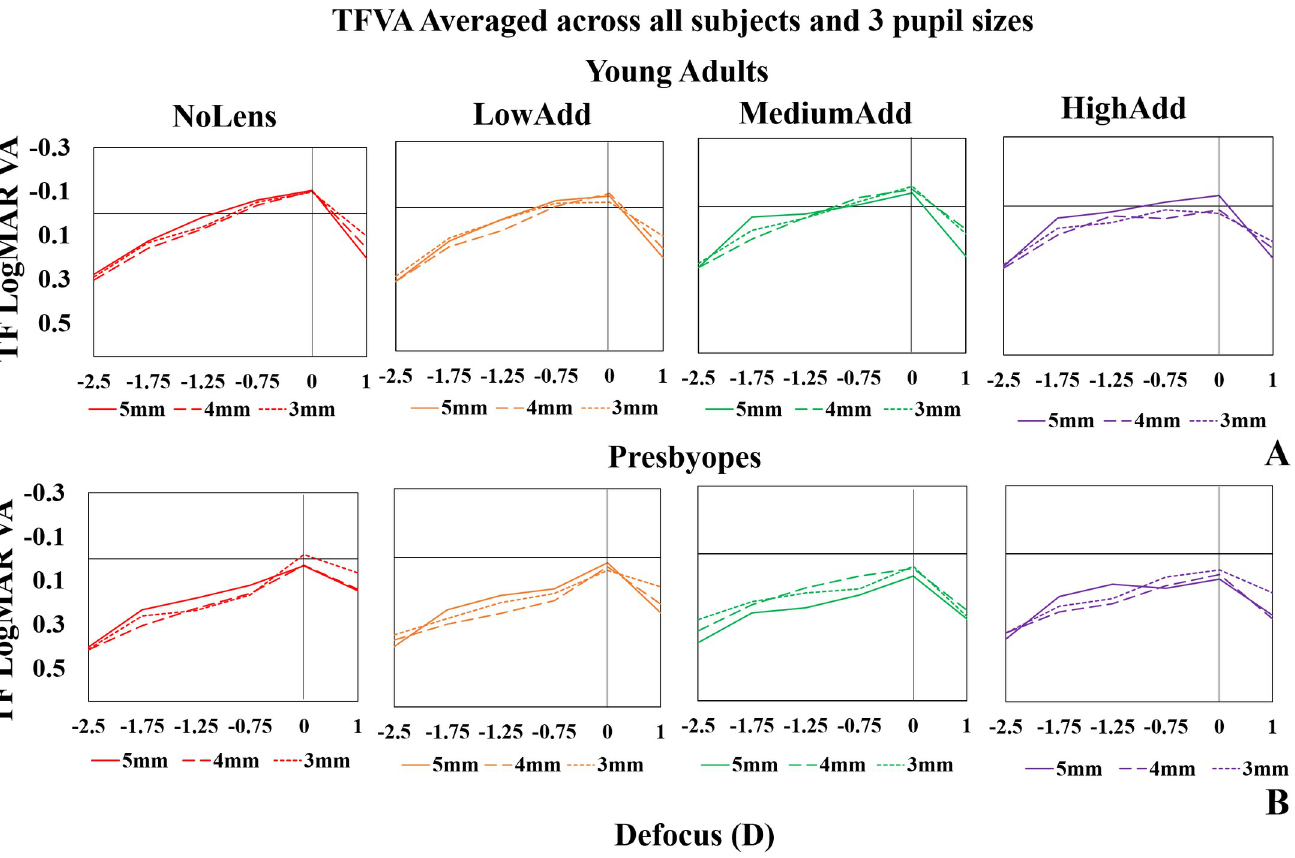
Fig 6. Average TF VA for 3 pupil diameters (3, 4 and 5-mm) under paralyzed accommodation. Lens condition identified by color—Red: NoLens; Orange: LowAdd; Green: MediumAdd; Purple: HighAdd. (A) young adults; (B) presbyopes.